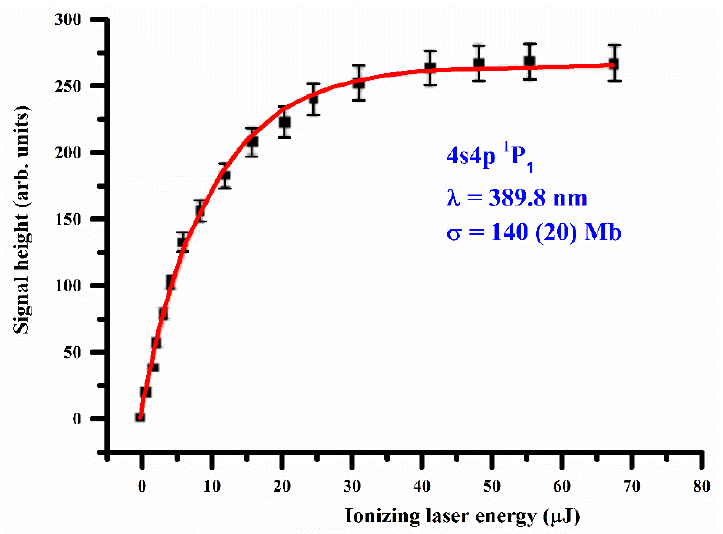
Figure 7. Photoionization signal for the 4s4p 1 P 1 level at the ionization threshold of calcium versus the ionizing laser energy.